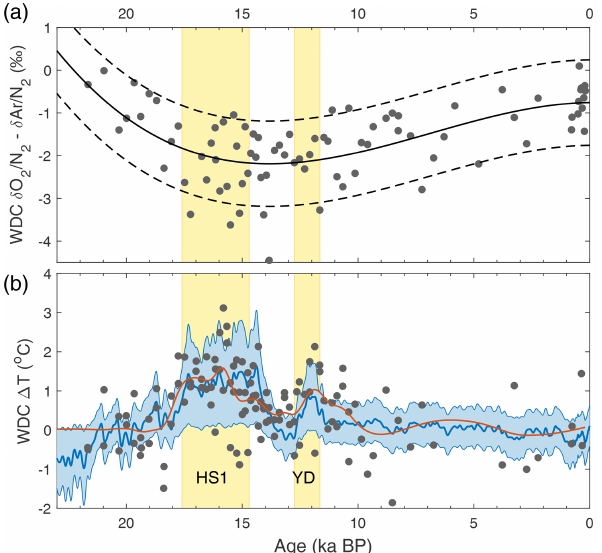
Figure B1. High-resolution sub-annual sampling of 86 Kr xs40 at the DE08-OH site. The annual layer thickness at this depth is around